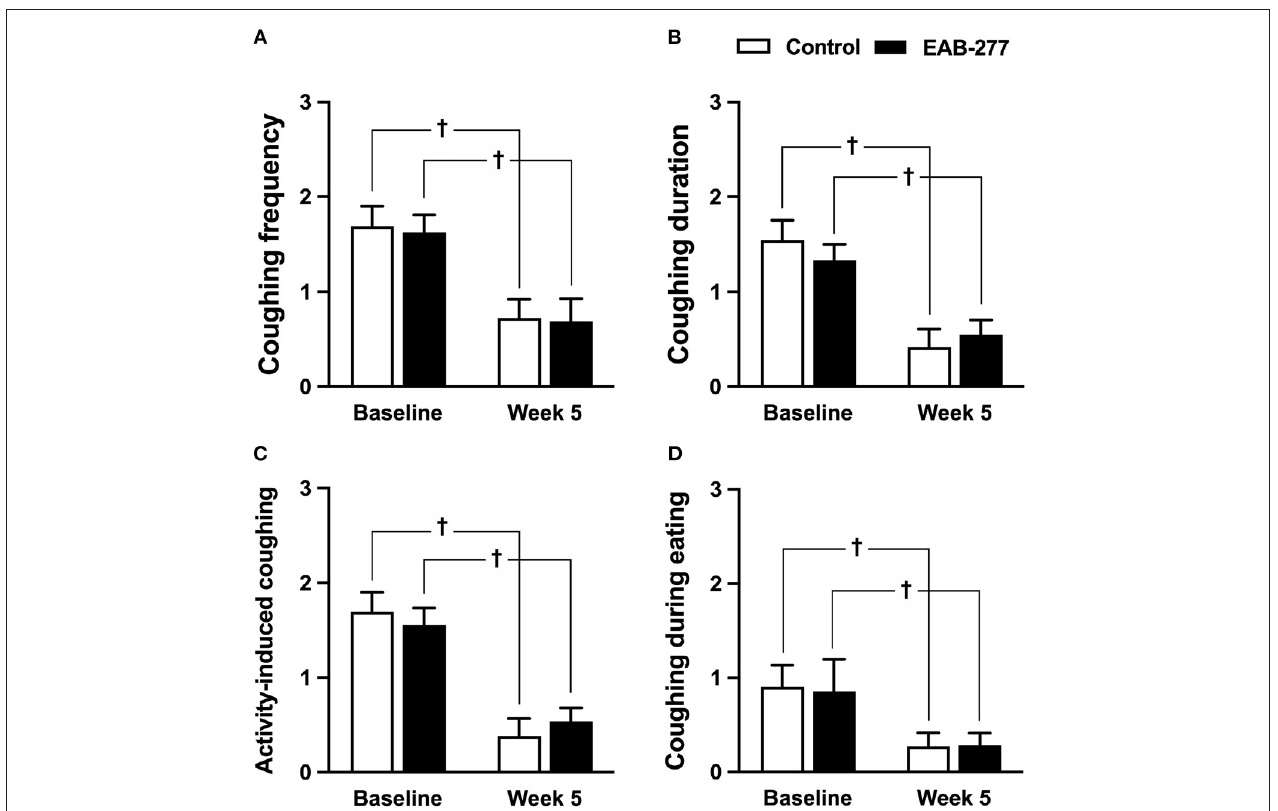
FIGURE 2 | Clinical signs of tracheal collapse at baseline and at week 5 were evaluated by questionnaire in the control and EAB-277 ® groups. All clinical signs, (A) coughing frequency, (B) coughing duration, (C) activity-induced coughing, and (D) coughing during eating, at baseline were not different between the groups. After treatment for 5 weeks, the clinical signs as evaluated by questionnaire were improved in both the control group and the EAB-277 ® group compared to baseline in the same group. † P ≤ 0.05 compared to baseline in the same group.